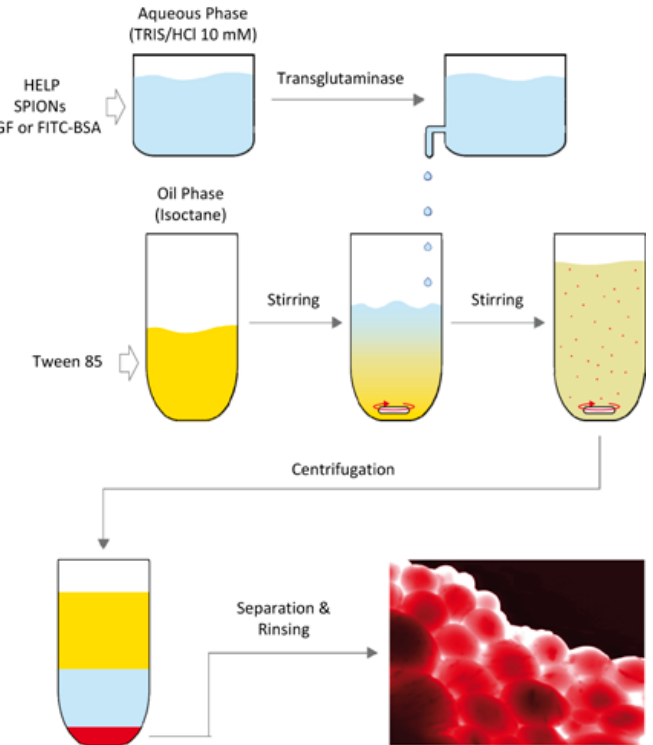
Figure 2. Preparation for the magnetic human elastin-like polypeptide (HELP) microparticles with various controlled drug-delivery applications. (Reproduced with permission from Reference [72], John Wiley and Sons).